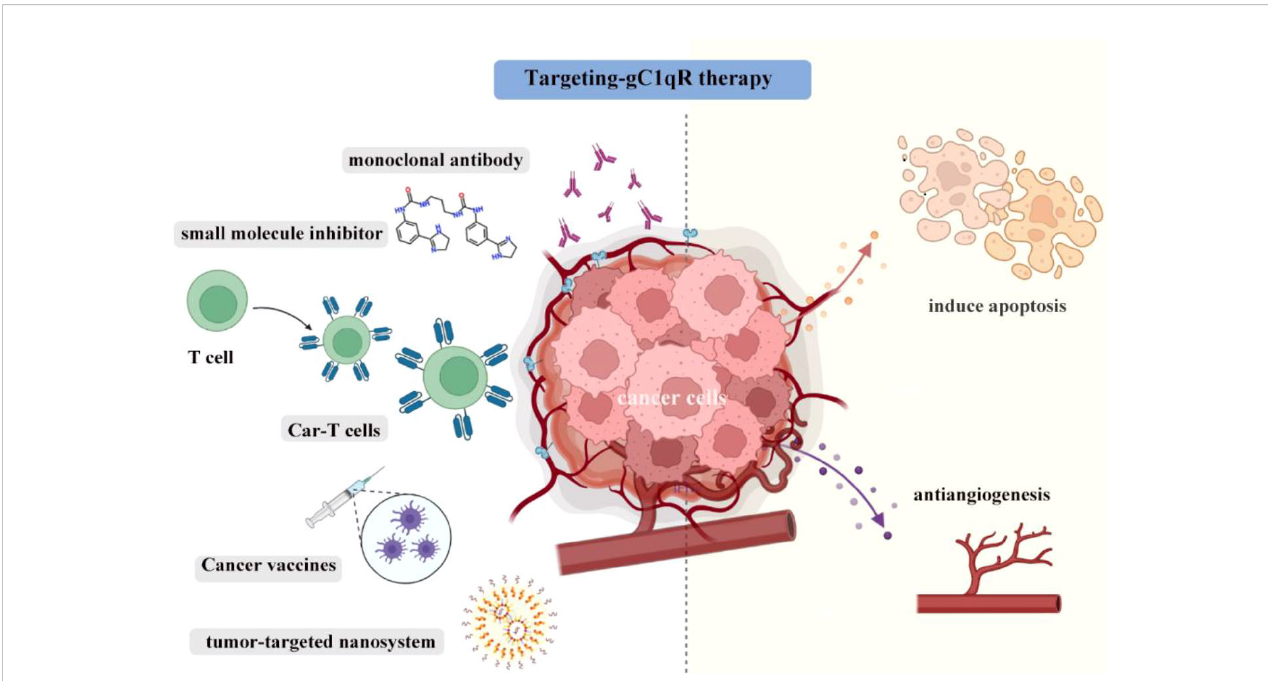
FIGURE 2 The gC1qR blockade can be largely classi fi ed into monoclonal antibody therapy, highly selective small molecules, CAR-T therapy, tumor vaccination and used in nanosystem to kill tumors. Induction of tumor cells apoptosis and antiangiogenic activity are key element in successful and ef fi cient gC1qR